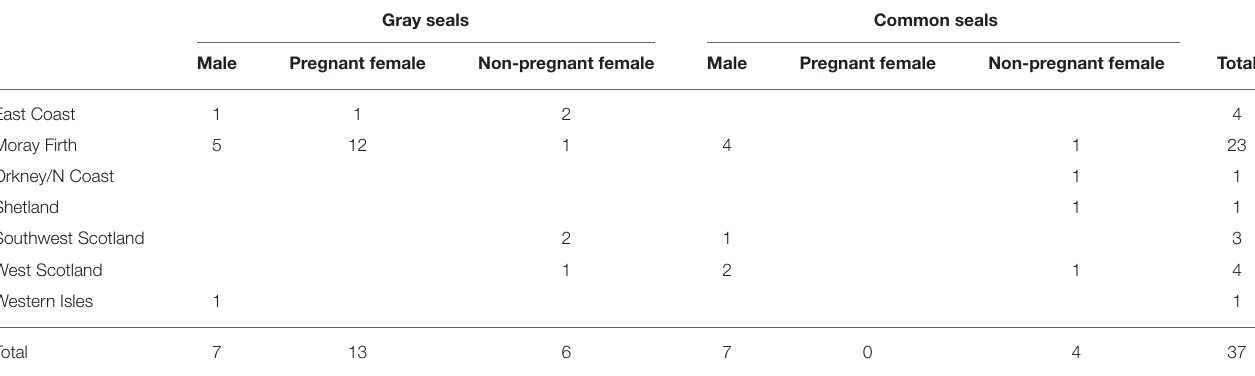
TABLE 7 | Species, sex, and reproductive state of shot seals necropsied by Scottish Marine Animal Stranding Scheme (SMASS) and Sea Mammal Research Unit (SMRU) by Seal Management Area 2011–2014 (SRUC Wildlife Unit, 2012; Brownlow and Davison, 2013, 2014; Davison N., 2015, pers.